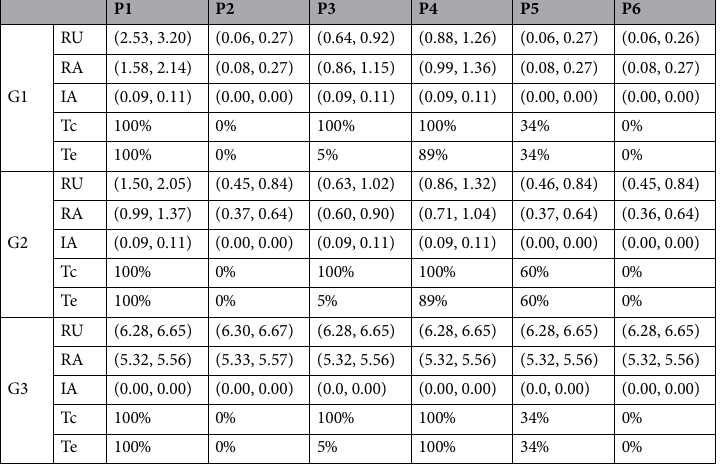
version of the proposed average control policy while countries 2, 4, 6, and 8 are fully closed to inbound travel. We used the same outcome measurements as in the previous simulation. Finally, we also evaluated the global coordination effectiveness by averaging the above measurements for all countries. Table 2 reports the effectiveness of different coordinated responses in the three groups of countries along with a global average. Under S4, where all countries use the proposed average control policy, the expected inbound travel increased up to 50% of normal travel, and the global pandemic situation was similar to that seen in sce- narios where the borders are closed. These findings demonstrate that a global response is critical for containing the pandemic while maximizing safe travel. Real data analysis. We used pandemic data from the Johns Hopkins University coronavirus data repository through May 31, 2020 25 . Flight data are from the Official Airline Guide (OAG). Because only data for January and February 2020 are available from OAG, we estimated flight data for other time periods using the OpenSky Network database 26–28 . This database tracks the number of flights from one region to another over time, which can be used to calculate the rate of flight reduction and to estimate flight data for other months. We considered the starting day for each country to be the first day the country exceeded 500 total confirmed cases, because the estimation for the number of undetected infectious people is unstable during each country’s early pandemic period. For similar reasons, we only analyzed the 92 countries whose total number of confirmed infected cases exceeded 500 by April 15, 2020. For the modeling purpose, the remaining countries were combined into a single fictional country labeled “Other.” Here, “Other” represents an amalgamation of countries with very few cases. We assume that most outbound travelers from this country are susceptible; we randomly assigned them a combina- tion of parameters consistent with a small value of R 0 when running the global model. The inbound and out- bound travel flows of the underlying small countries are combined in a single daily inbound and outbound flow. To demonstrate the ability of our model to capture the real evolution of the pandemic, we fit it to real data as follows. The fitting period starts when a country exceeds 500 total confirmed cases for the first time before May 31, 2020. The transmission rate α may change during the study. Here, we allow two different values for α for each country, denoted by α 1 and α 2 ; both need to be estimated from data and the location of the country specific change point also needs to be estimated from data. Figure 2 shows the fit of our model for eight countries with the highest number of accumulated confirmed cases up to May 31, 2020. Overall, the figure shows that our model effectively captures the real data (red), as the estimated line (blue) is very close to the observed line and is contained within the confidence interval. To understand how different travel restriction policies affect the pandemic both globally and in each country, we used the estimated parameters for all countries before May 31 together with the travel data to simulate the course of the pandemic during the first 14 days of June 2020 under four different travel regulation scenarios. In the first scenario, where all countries are fully open, we used 2019 travel data from the pre-pandemic period. In the second scenario, we used 2020 travel data during the COVID-19 pandemic. In the third scenario, all